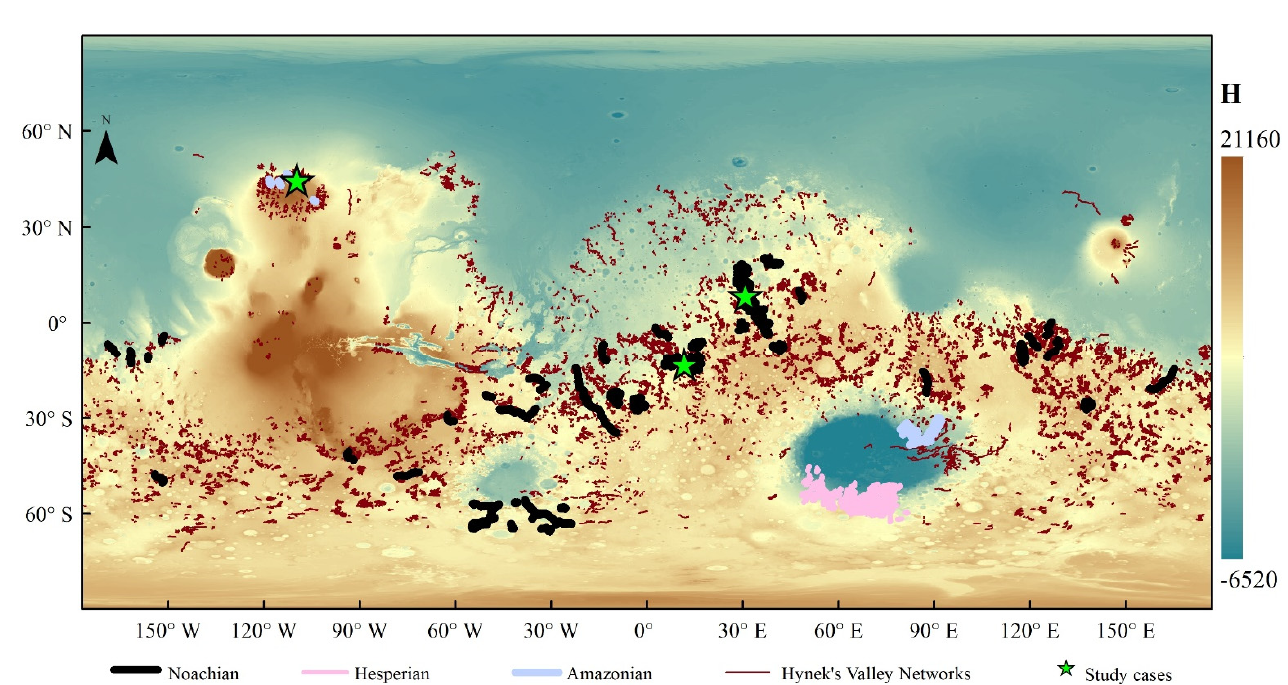
Figure 3. The studied valley networks on Mars. The blue, pink, and white colors represent the valley networks formed during the Amazonian, Hesperian, and Noachian, respectively. The crimson lines denote the global valley network system on Mars recognized by Hynek 2010 and Alemanon 2018. The base map is MOLA DEM.